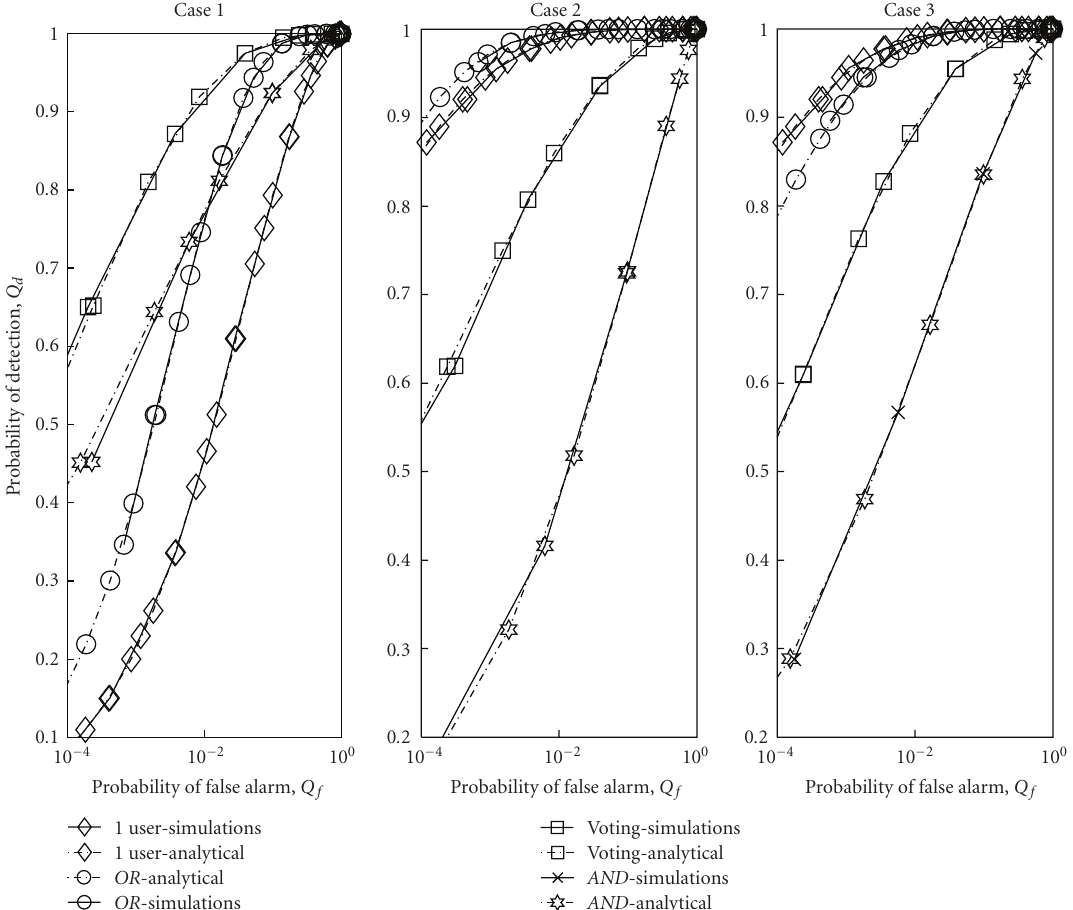
Figure 7: Receiver operating characteristics for 5 collaborating users in AWGN Channel in 3 cases: Case 1 (all users have similar SNR), Case 2 (half of the users have high SNR), and Case 3 (only one user has high